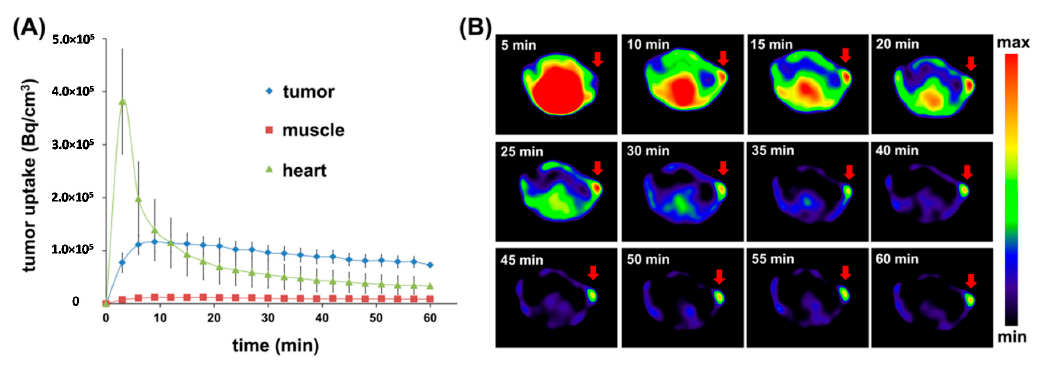
Figure 4. ( A ) Time-activity curves (TACs) of 99m Tc-HYNIC-D 1 -FA 2 in KB tumor-bearing mice derived from the 60 min dynamic SPECT/CT scan; ( B ) Transversal tumor SPECT images at different time points of image acquisition.